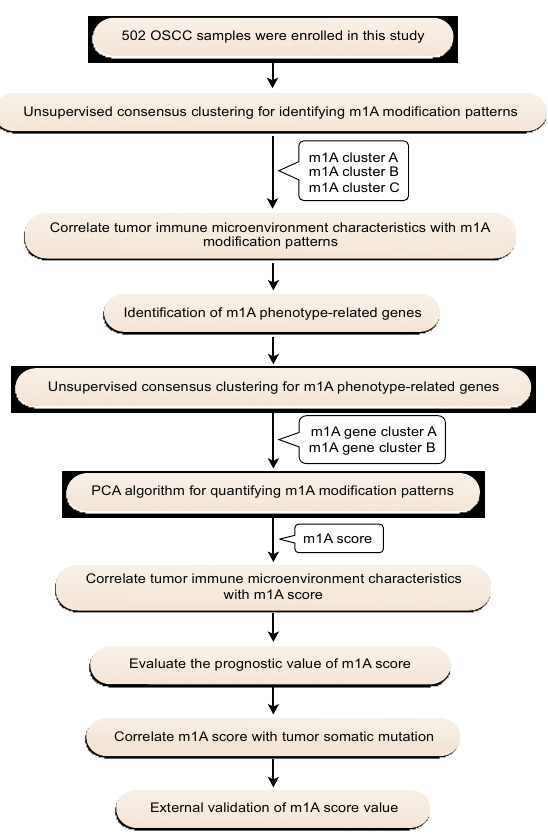
Figure 1. Flowchart of the study design.